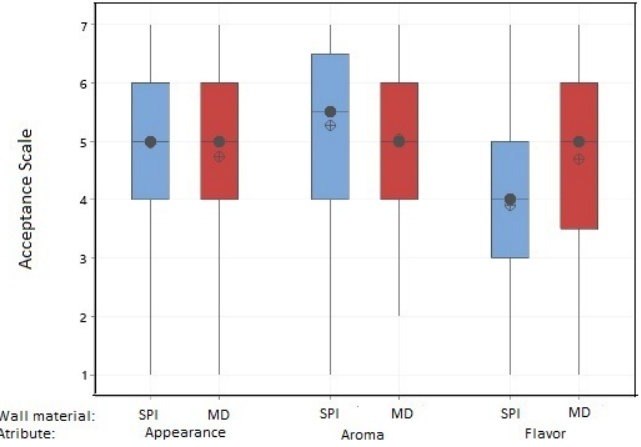
Figure 5. Statistical Analysis (U test Mann-Whitney) for yogurt with added muicle extract MD and SPI microcapsules. 1 = Dislike Very Much, 2 = Dislike Moderately, 3 = Dislike Slightly, 4 = Neither like nor dislike, 5 = Like Slightly, 6 = Like Moderately, 7 = Like Very Much.